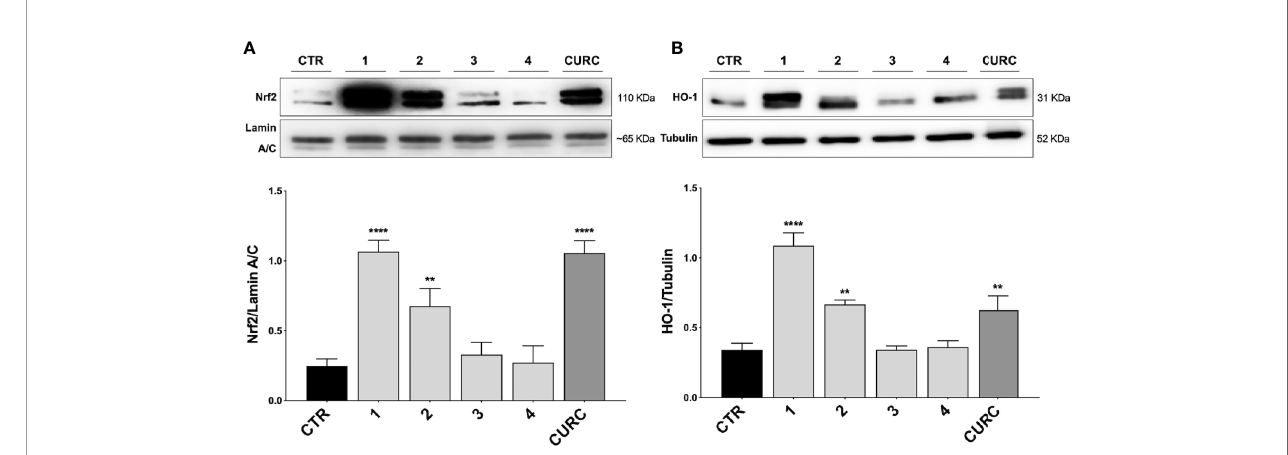
FIGURE 2 | Nrf2 nuclear translocation and modulation of HO-1 protein content in THP-1 cells. (A) THP-1 cells were treated with compounds 1 – 4 and CURC at a concentration of 5 m M for 3 h. After isolation, nuclear extracts were examined by Western blot analysis and Nrf2 expression was determined using an anti-Nrf2 antibody. Anti-lamin A/C was used as protein loading control. Results are shown as means of Nrf2/lamin A/C ratio ± SEM. Dunnett ’ s multiple comparison test; ** p < 0.01 and **** p < 0.0001 versus CTR; n = 5 – 7. (B) Total protein extracts of THP-1 cells, treated with compounds 1 – 4 and CURC at the concentration of 5 m M for 24 h, were analyzed for HO-1 protein content by Western blot analysis. Anti-tubulin was used as protein loading control. Results are shown as means of HO-1/ Tubulin ratio ± SEM. Dunnett ’ s multiple comparison test; ** p < 0.01 and **** p < 0.0001 versus CTR; n = 7.